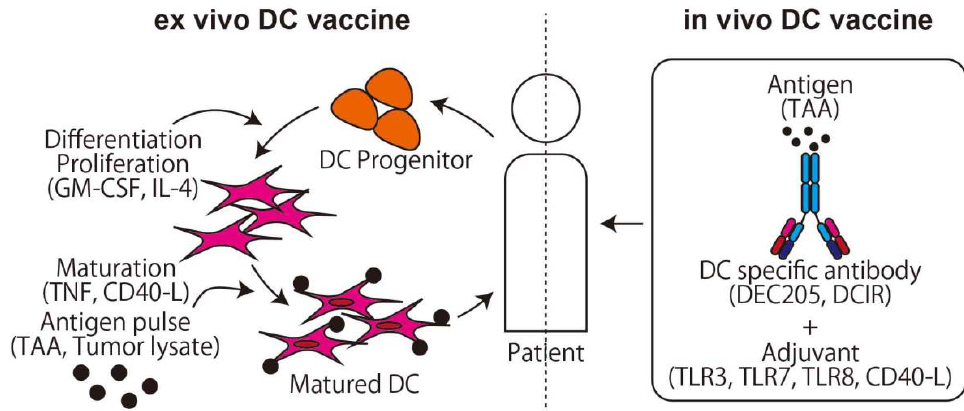
Figure 2. The two main methods of dendritic cell (DC) vaccine. The ex vivo DC vaccine uses the method of adoptive immunotherapy. The in vivo DC vaccine uses a specific antibody conjunction with an antigen that targets DCs and activates T-cells via cross presentation.